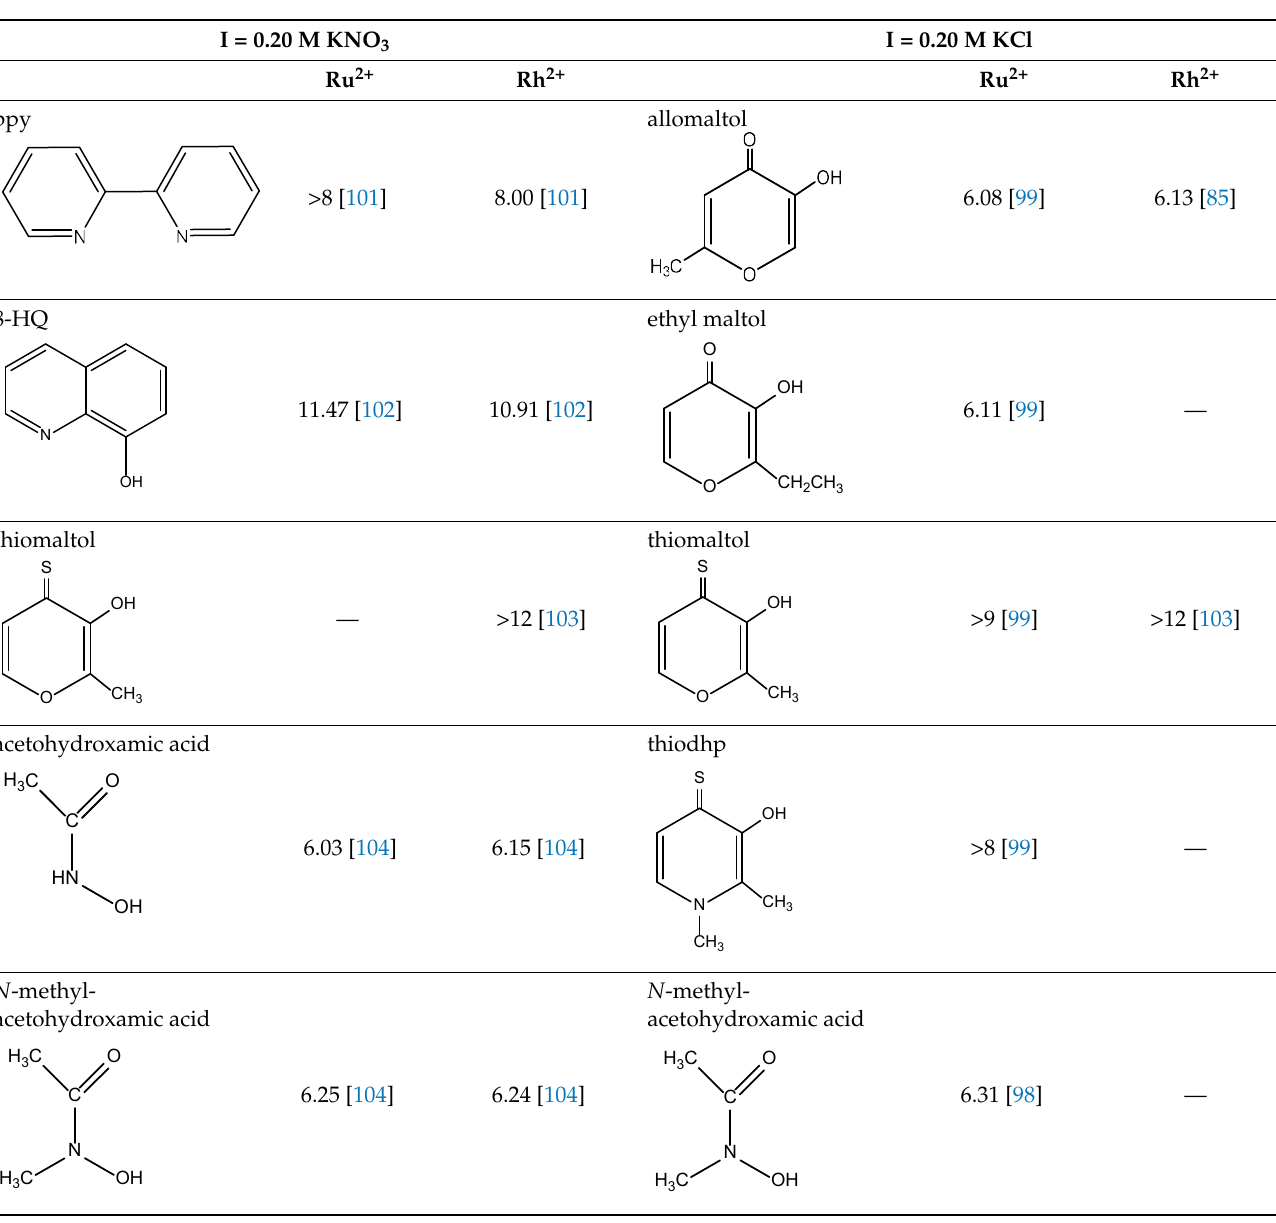
The pM’ 1:1 values in Table 4, and the corresponding values in Table 1, are used to make a comparison between the metal-binding effectivity of the various bidentate (N,N), (N,O), (O,O), and (S,O) chelators and the binding effectivity of the amino/imidazole/peptide hydroxamate derivatives at pH = 7.4 without any ligand excess at c M = c L = 1 × 10 − 6